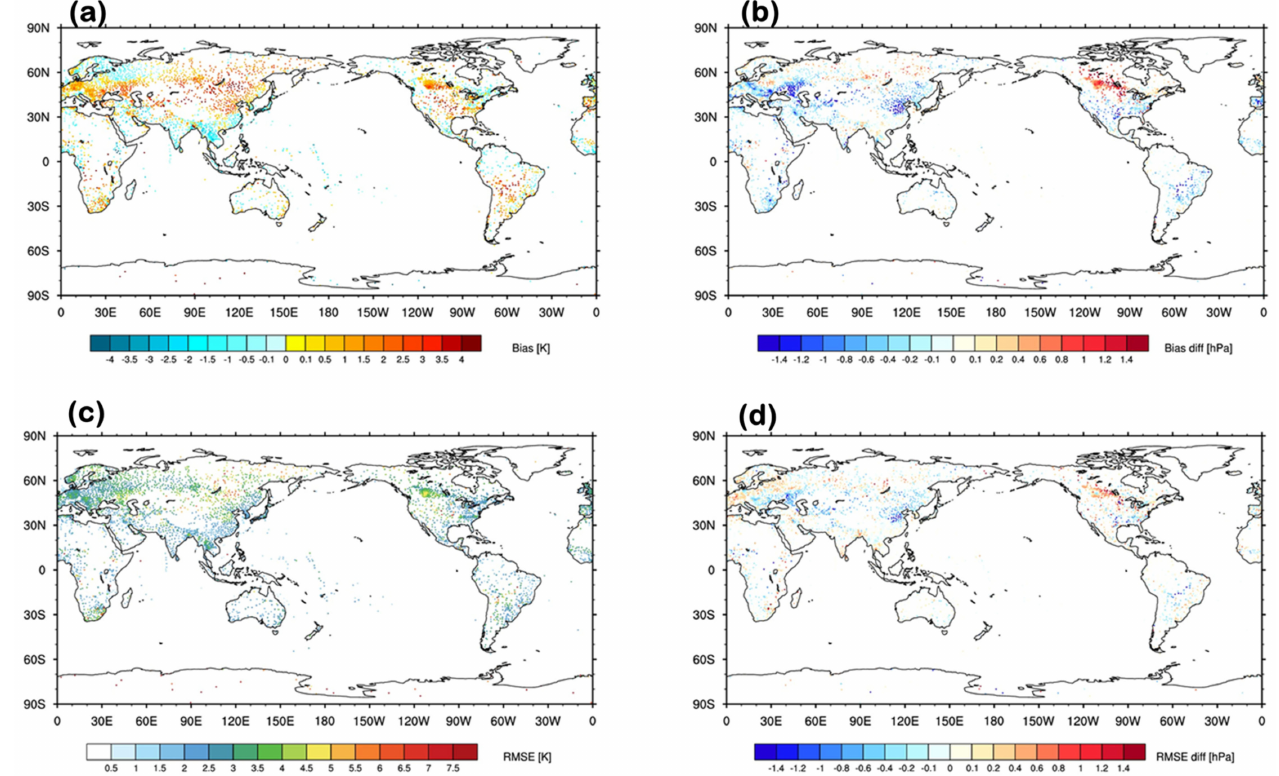
Figure 14. ( a ) Biases and ( c ) RMSEs of near-surface air temperature in the CTL against the near-surface observations, and differences in ( b ) biases and ( d ) RMSEs between the EXP and CTL for a five-day forecast.